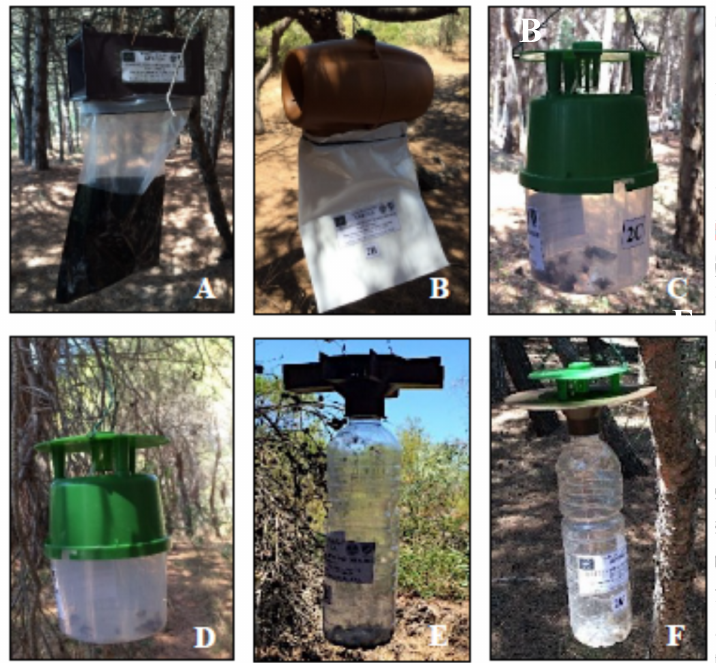
Figure 2. Funnel trap devices that were tested in trapping of T. hellenica and T. pityocampa male adults: G-Trap ( A ), Flysan ( B ), Lepisan ( C ), Lepisan plus ( D ), Prototype 5 ( E ), Prototype 6 ( F